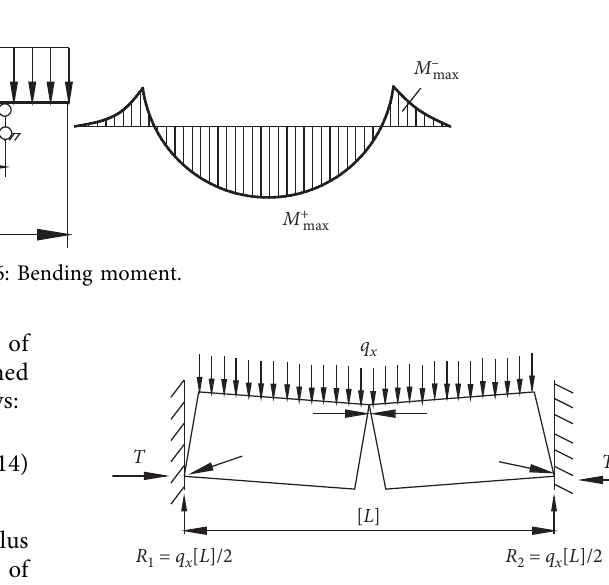
Figure 7: An articulated balanced structure of